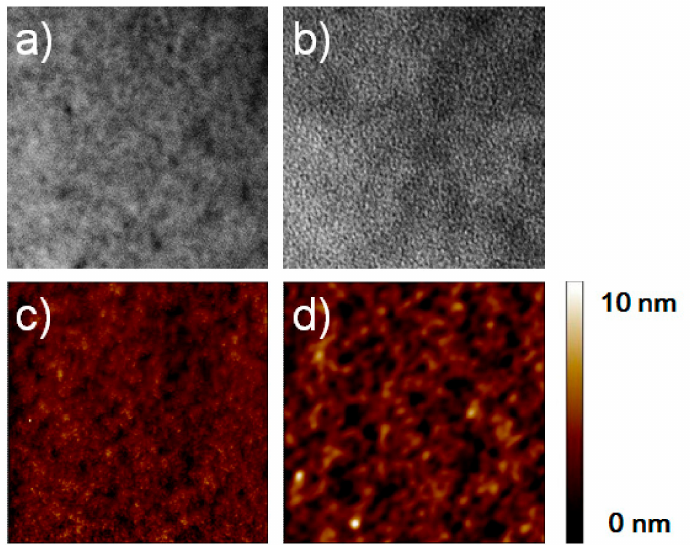
Figure 5. ( a , b ) TEM images of PTB7-Th: PPDI(H) blend film and PBDB-T: PPDI(H) blend films (the scan size is 10 µ m × 10 µ m); ( c , d ) AFM phase images of PTB7-Th: PPDI (H) blend film and PBDB-T: PPDI(H) blend films (scan size is 10 µ m × 10 µ